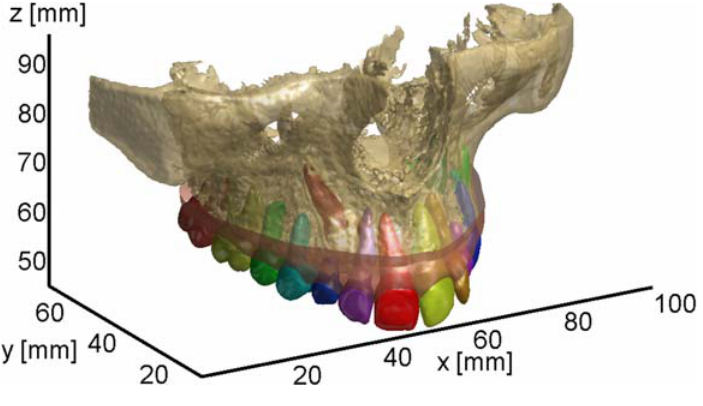
Figure 16. 3D views of the multi-body orthodontic model including maxilla, gingival tissue and individual teeth (crowns +